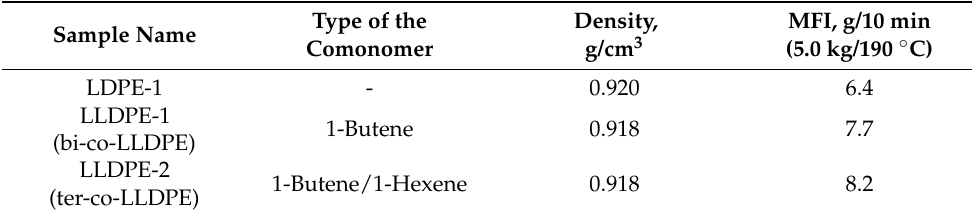
Table 2. Characteristics of the low-density polyethylene samples.